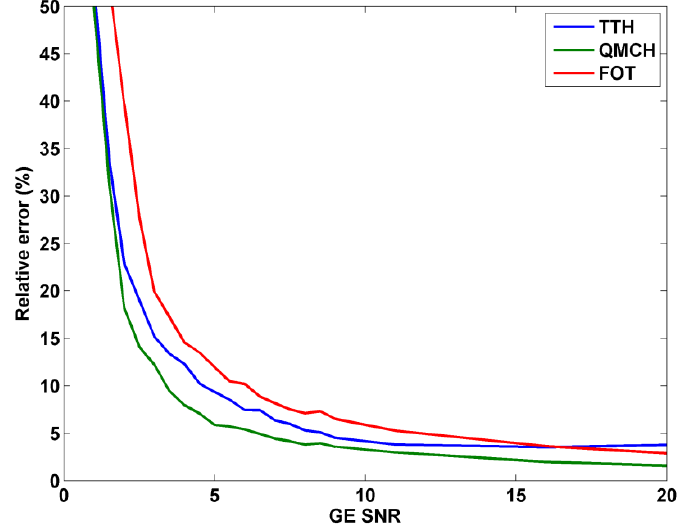
Figure 10. Uncertainties 1 on TTH , QMCH and FOT for different GE SNR. 1 Mean values for all sampling